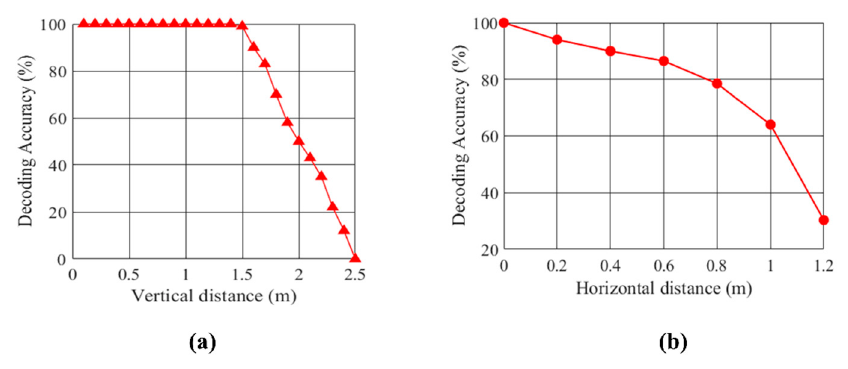
Figure 12. ( a ) Decoding accuracy vs. vertical distance; ( b ) decoding accuracy vs. horizontal distance.